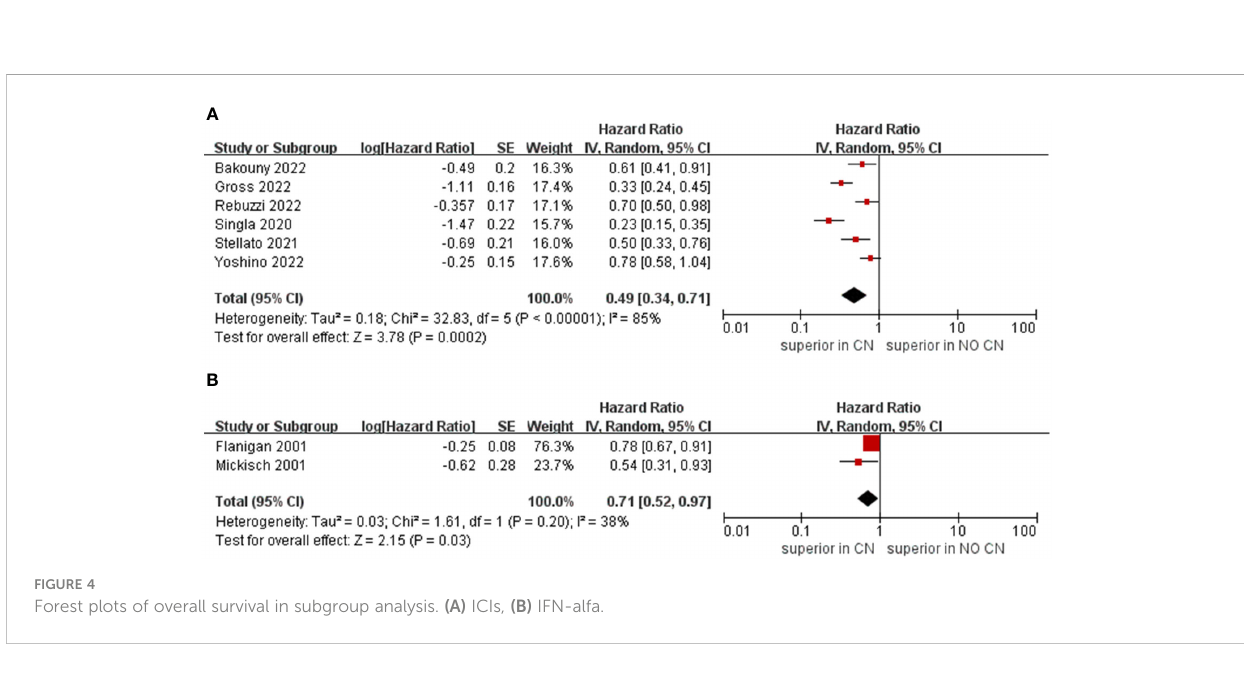
FIGURE 3 Forest plots of overall survival.